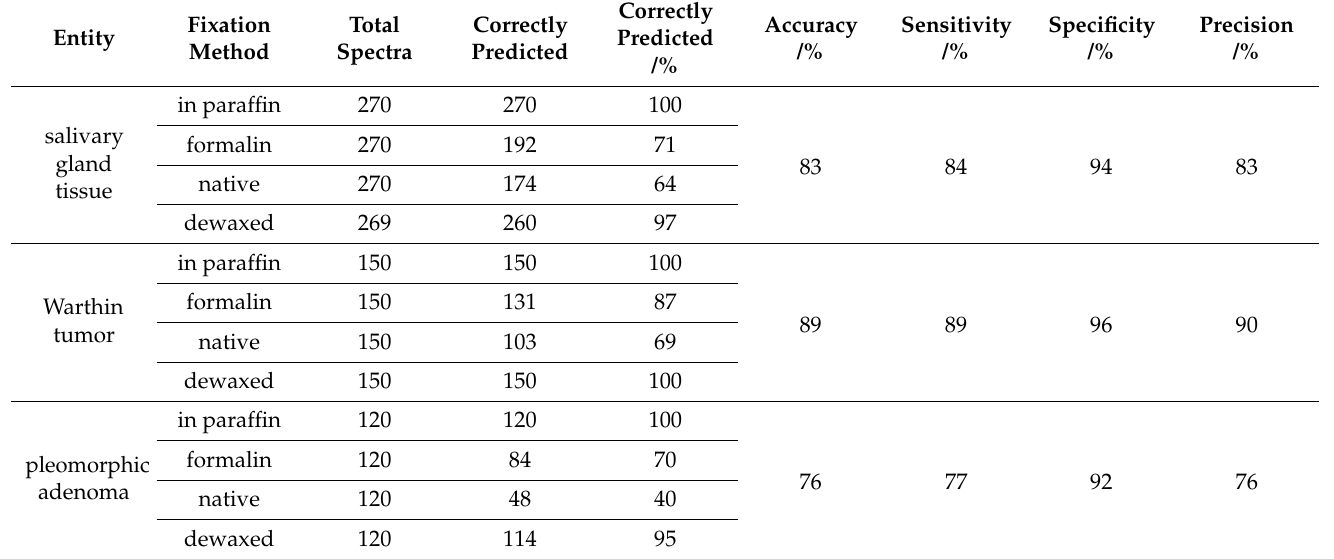
Table 2. Model quality parameters for the salivary gland tissue, Warthin tumor and pleomorphic ade- noma PCA-DA models. The robustness of the models can be deduced from the total and percentage amount of correctly assigned FTIR spectra for each preservation method. Based on this assignment, the average model parameters accuracy, sensitivity, specificity and precision can be